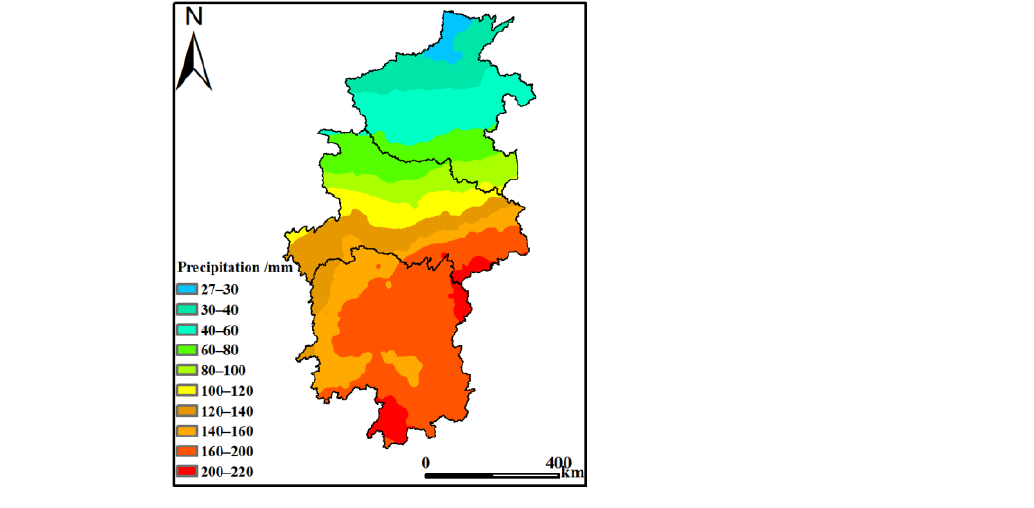
Figure 8. Average of TRMM data with spatial resolution of 1 km in Central China from 2000 to 2017 in April.